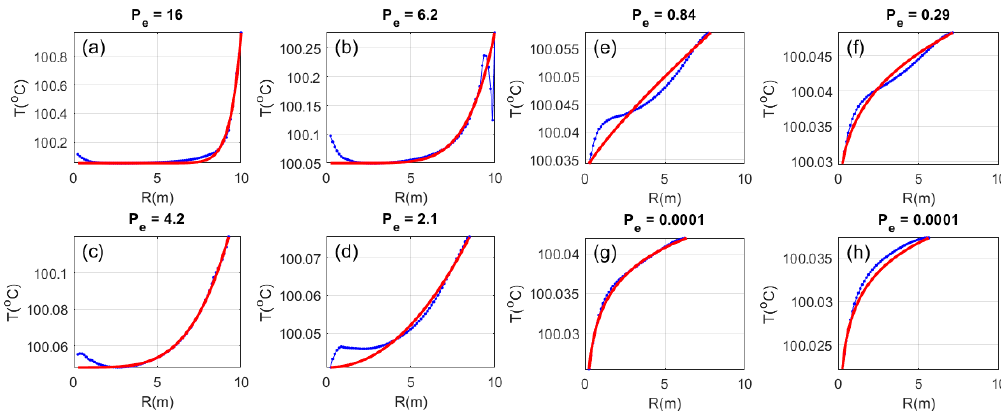
Figure 11. 2D analytic wellbore-centric radial temperature profiles (Equation (5), red traces) for given Peclet number matched to 3D numerical model radial temperature distributions (blue dots) for 30 cm radius wellbore embedded in 10-m radius crustal volume (Figures 6 and 7). Horizontal axes are wellbore-centric radius in meters; vertical axes are temperatures from nominal wellbore ambient T 0 ~ 100 to ambient crust T 1 ~ 100 ◦ C + ∆ T for ∆ T ~ 0.05 ◦ C except near the advective flow structure when ∆ T = 1 ◦ C. From upper left to lower right, plots ( a – h ) show the 3D model radial temperature distributions fit to 2D steady-state radial temperature distributions governed by Peclet numbers P e = r 0 φ v 0 /D at successive axial distances from the fluid influx fracture-connectivity structure. The Peclet number ( a ) at the fracture-connectivity structure is 16. Stepping away from the influx structure in 1.5 m intervals, Peclet numbers ( b – d ) decline as 6.2, 4.2, and 2.1; at wellbore axial offsets greater than 6 m from the fracture-connectivity structure, thermal conductivity values of Peclet numbers ( e – h ) edge to P e =